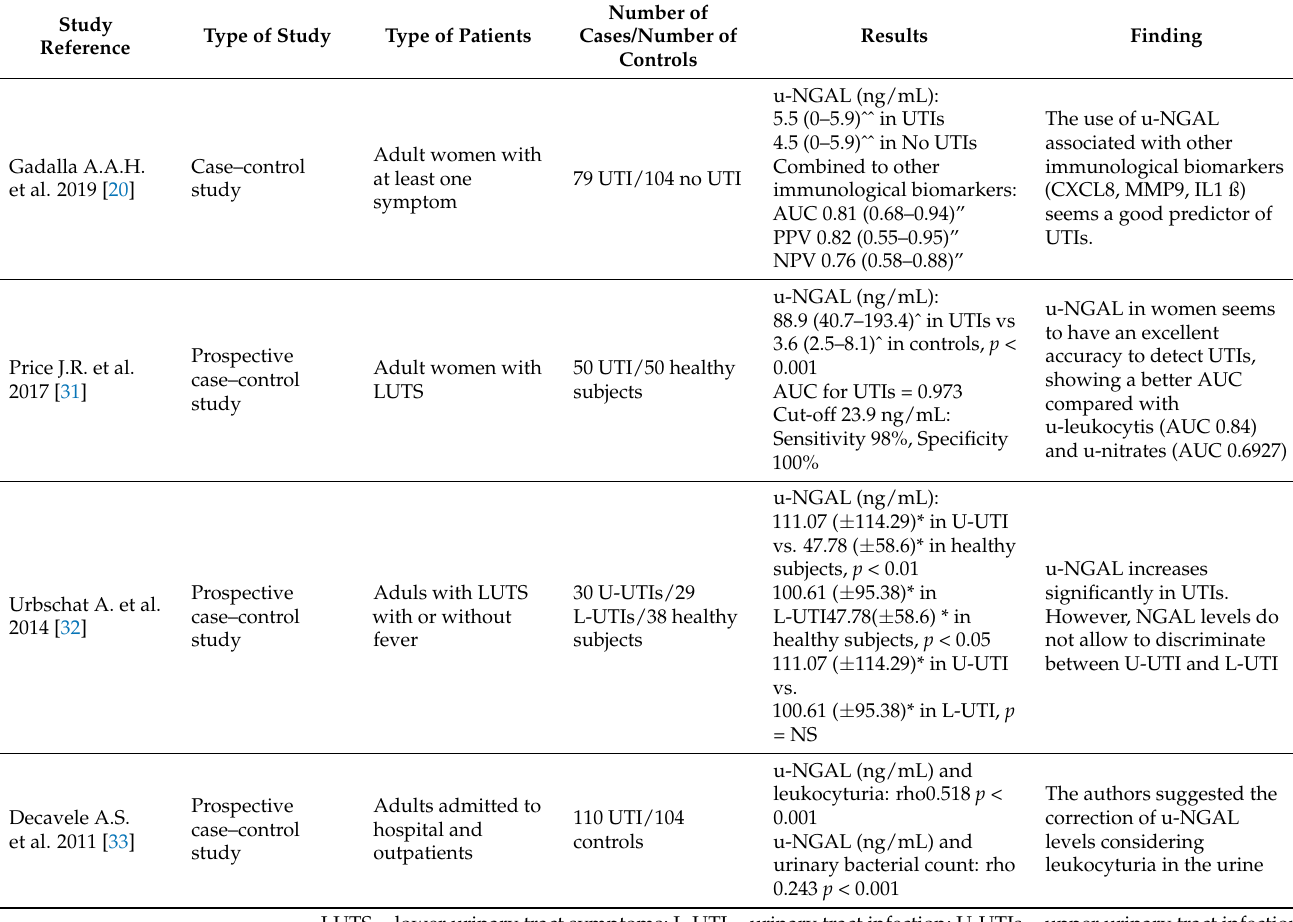
Table 3. Urine NGAL diagnostic value in UTIs; target population: